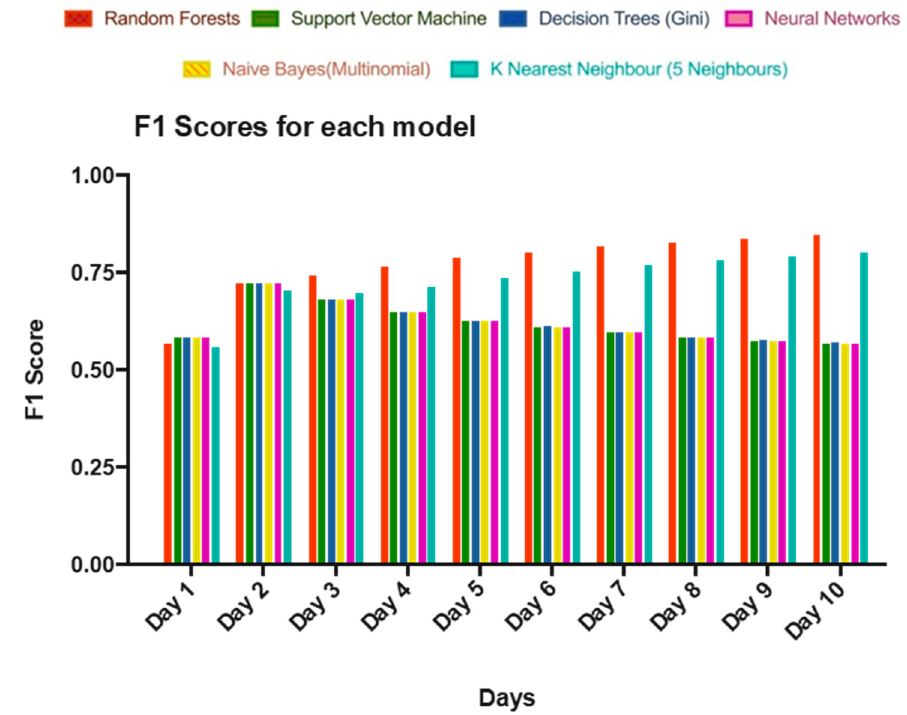
Figure 2. Performance of various classifiers. Most models make the most accurate predictions for 10th day ahead in the future.